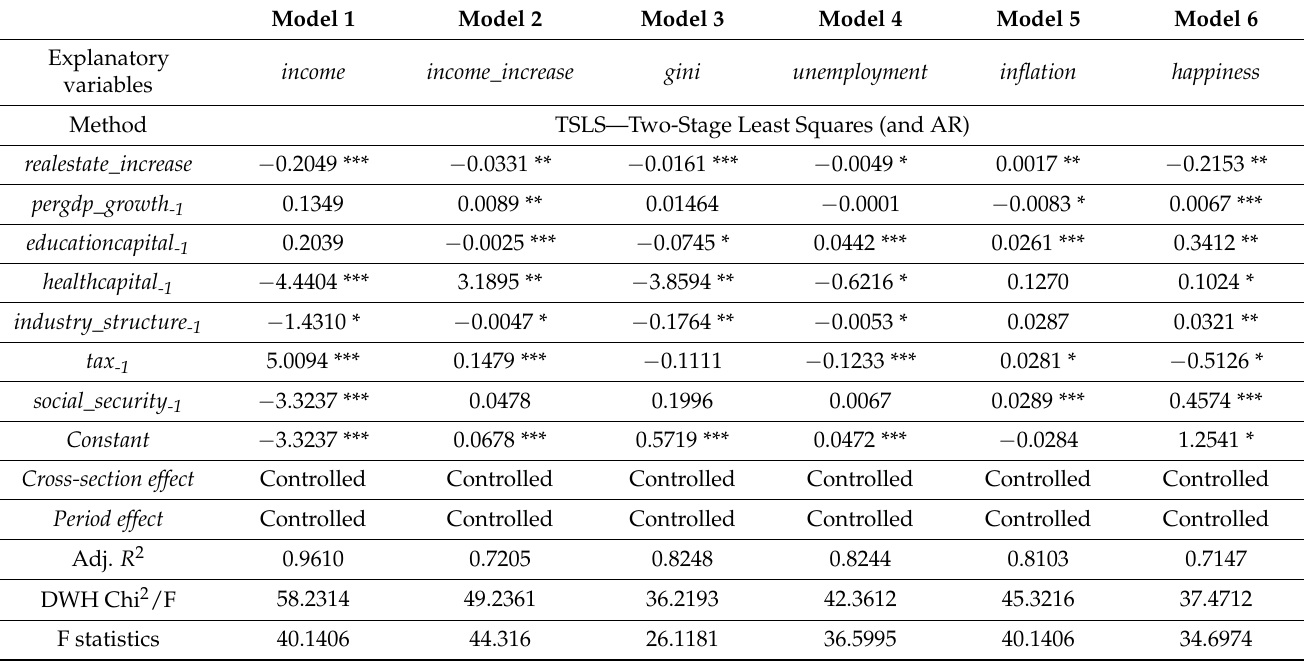
Table 2. TSLS test results of the impact of real estate investment growth on national